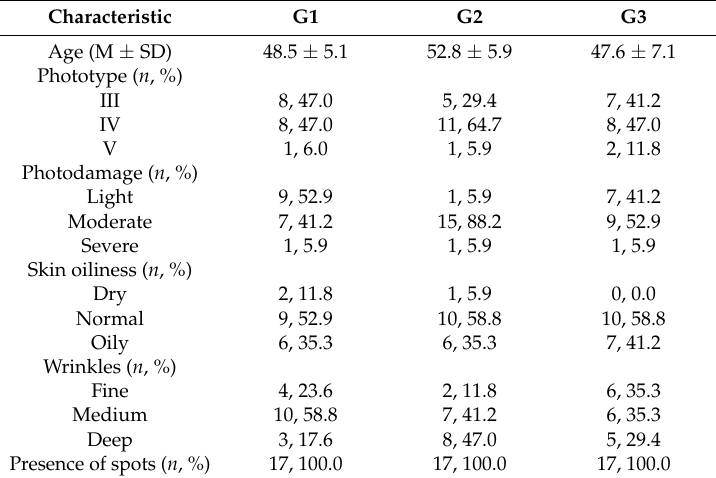
Table 1. Baseline characteristics of the